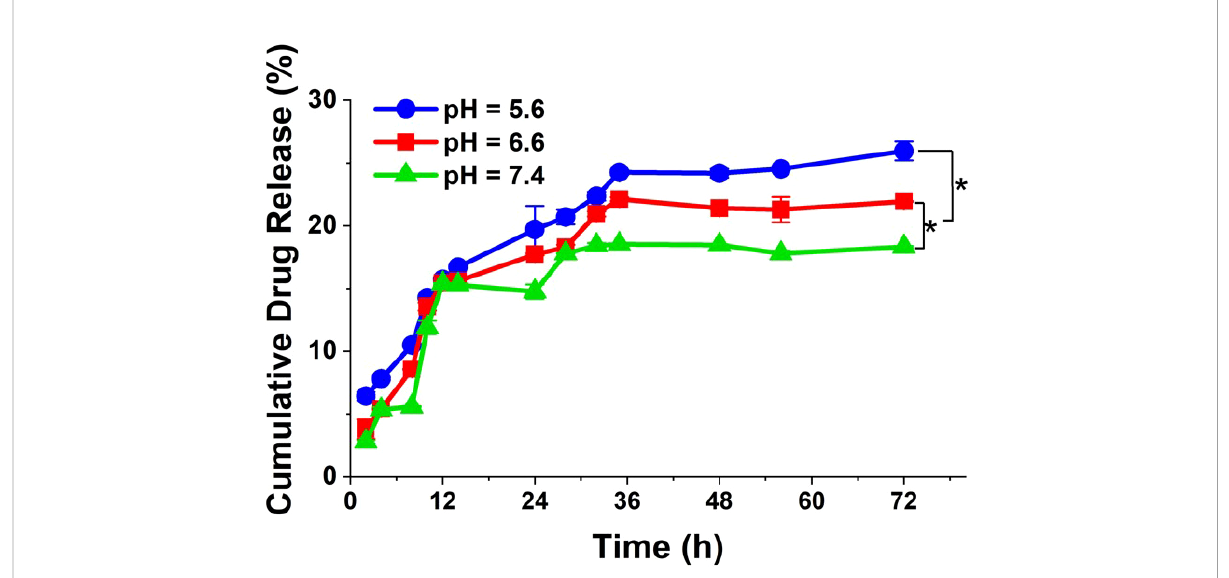
FIGURE 3 In vitro release pro fi les of DOX from DOX@NGO-BBN-AF750 under different pH values at 37°C. Data were obtained from n = 3 repeated experiments. * P < 0.05.